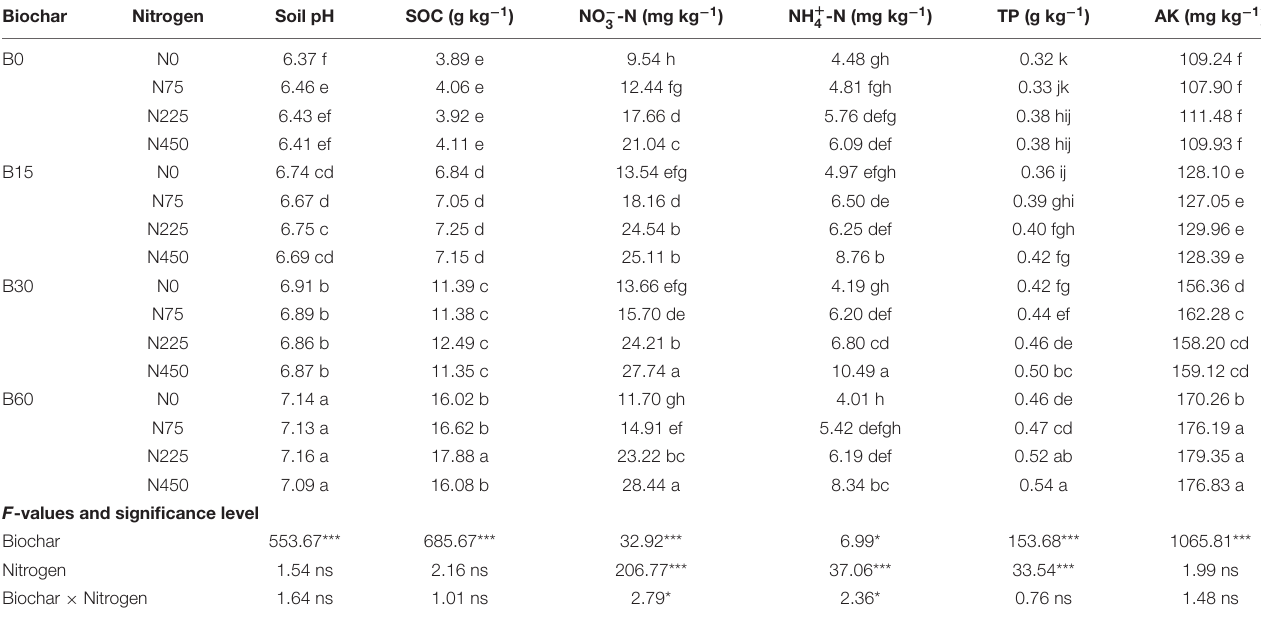
TABLE 2 | Integrated effect of biochar and nitrogen application on chemical properties of soil during 2019–2020. Biochar